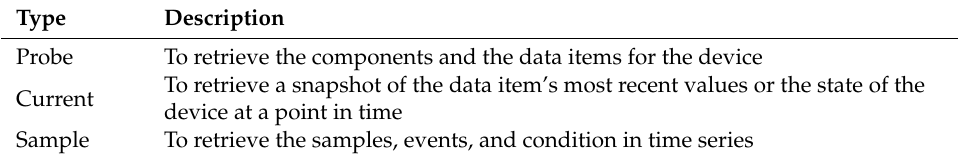
Table 2. Request types for MTConnect